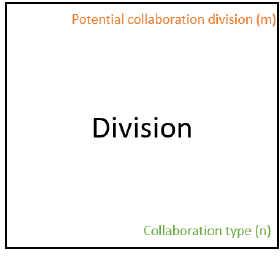
Figure 8. Single industrial type